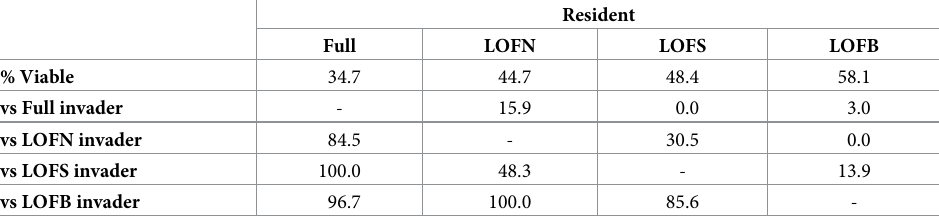
Table 2. Viability and competitive ability of each of our four strains (each column corresponds to a different resi- dent). The first row of the body (‘% Viable’) shows the percentage of parameter combinations for which each resident type was viable. The remaining rows show the percentage of parameter combinations for which the invasion was suc- cessful (conditioned on resident viability; left-hand column indicates which strain was the invader). Abbreviations in Fig